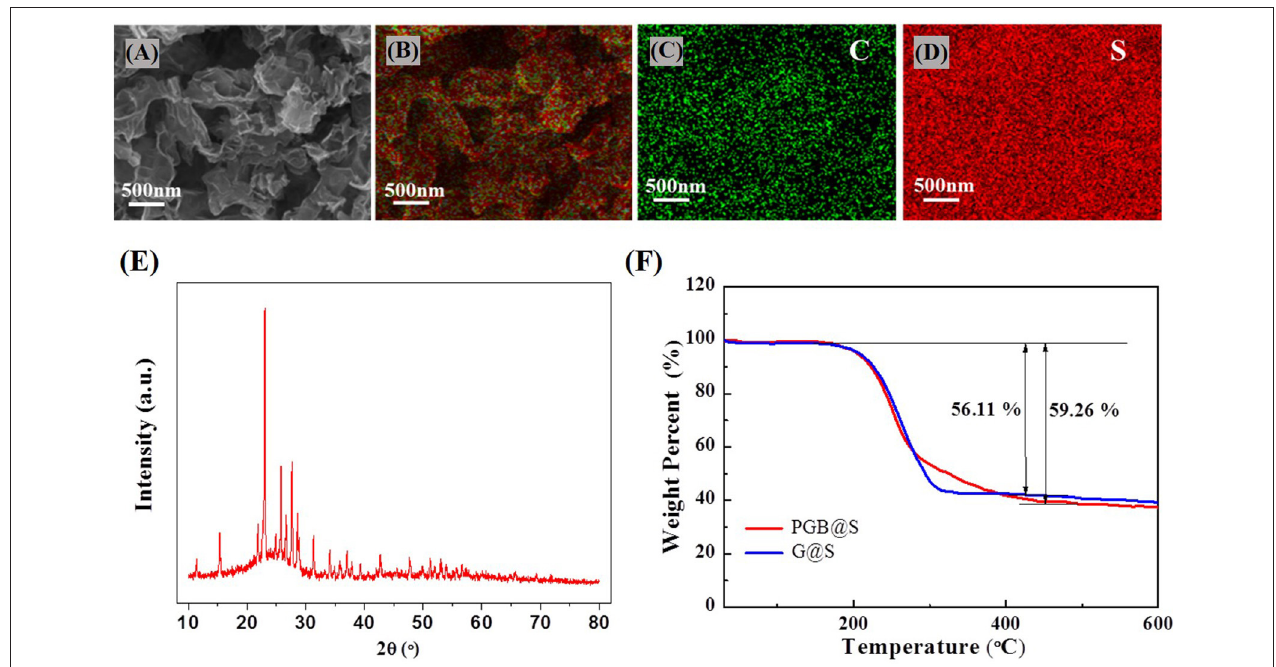
FIGURE 3 | (A) SEM images and (B) corresponding element mapping of PGBs@S, (C) carbon and (D) sulfur; (E) XRD spectra of PGBs@S; (F) TGA analysis of PGBs@S and